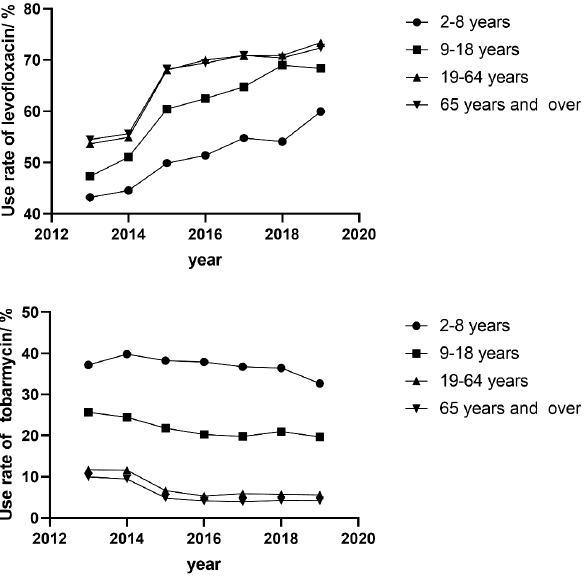
Figure 2. Trends in use rate of levofloxacin ( A ) and tobramycin ( B ).